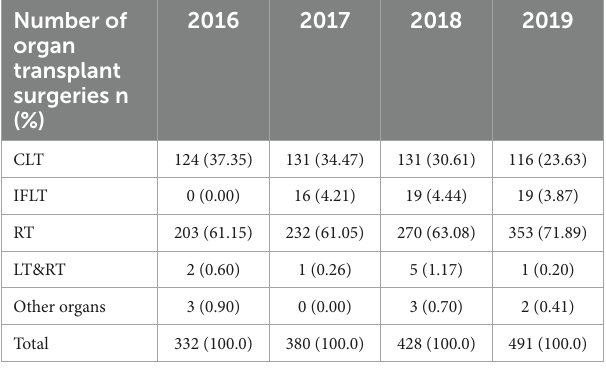
TABLE 6 Annual number of transplants performed in the department during the study